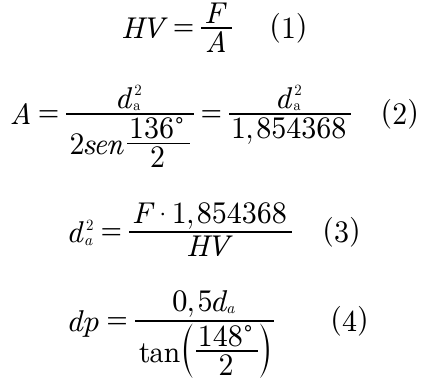
Torch stand-off distance (mm)